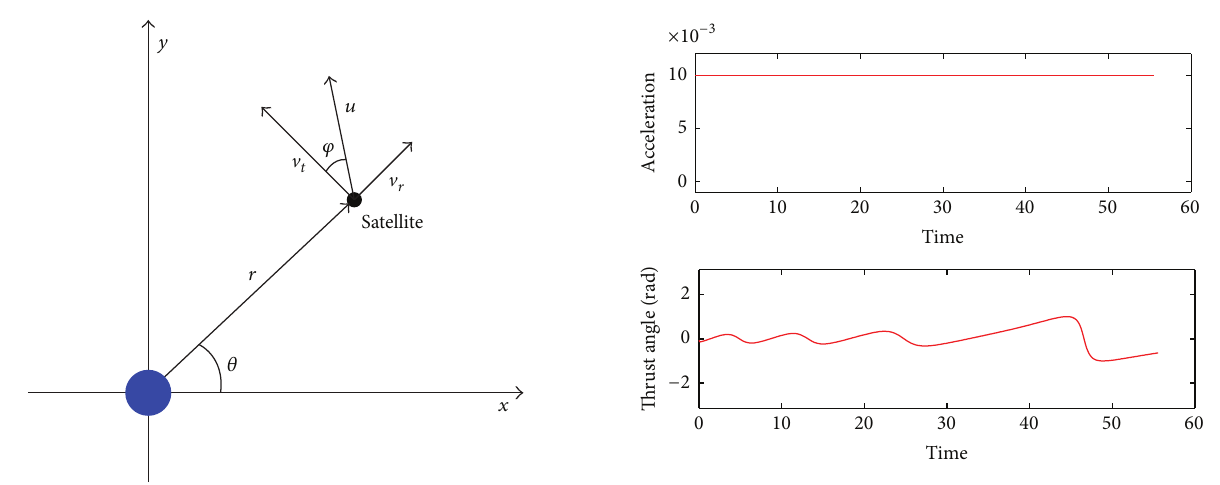
Figure 14: Time history of control variables.